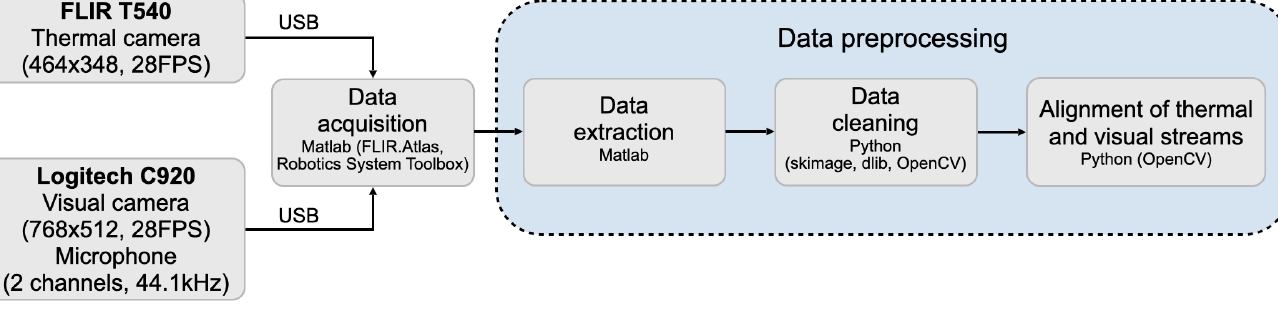
Figure 1. Data pipeline for